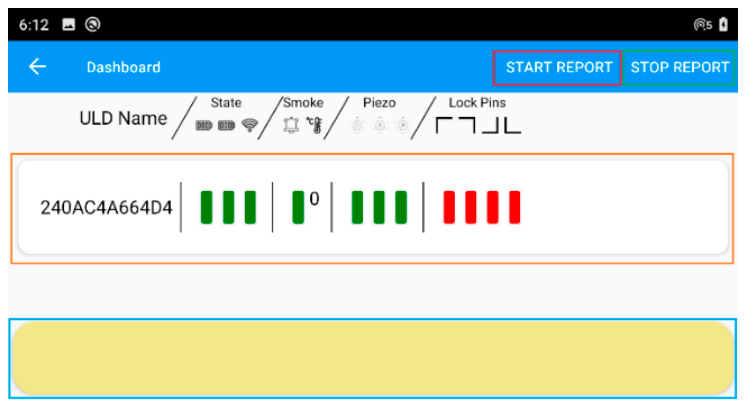
Figure 11. ULD Dashboard Page.